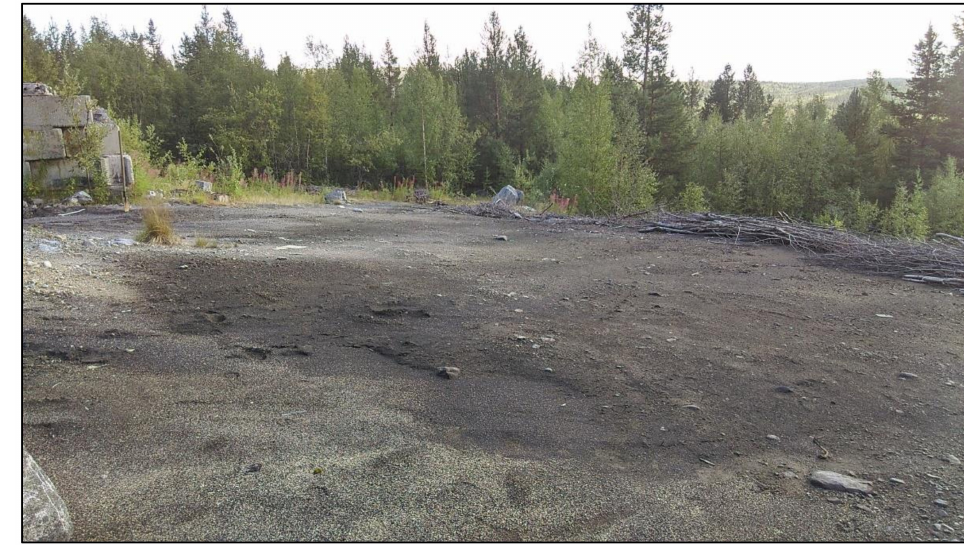
Figure 1. Contaminated